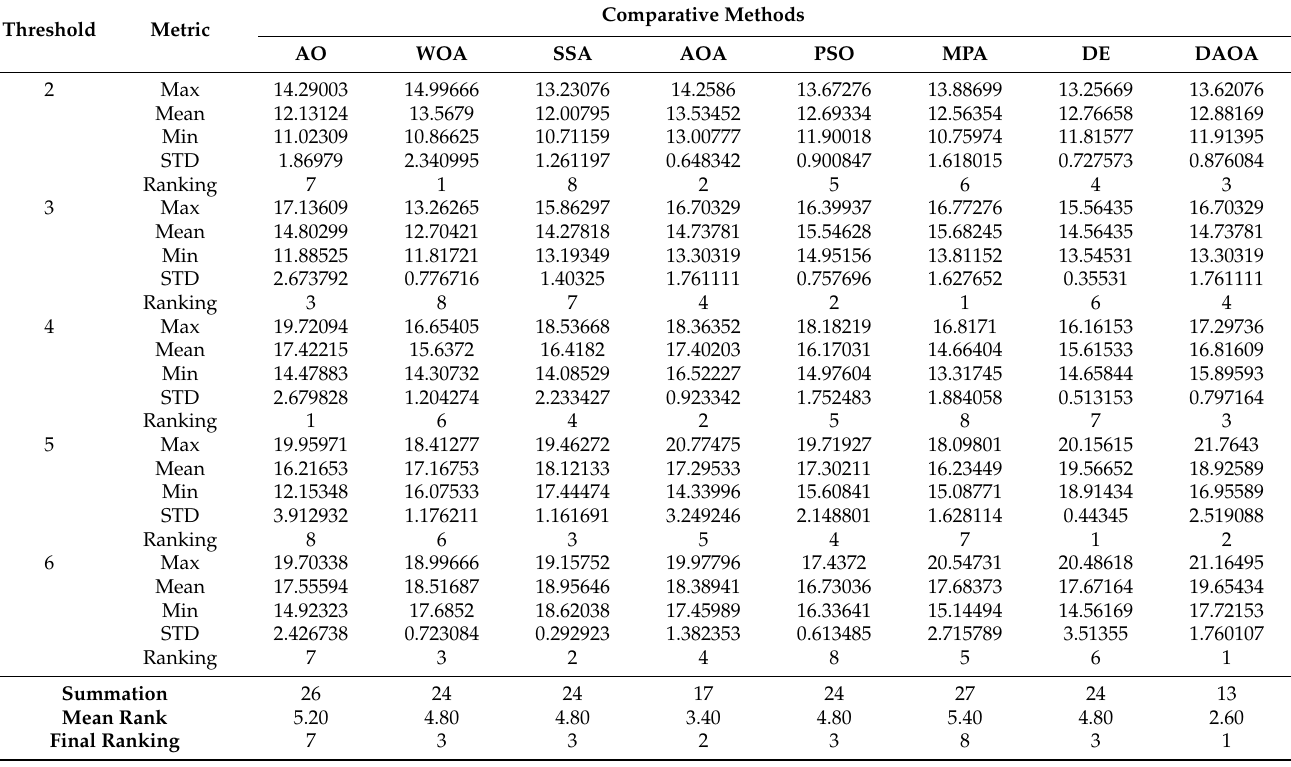
Table 12. The PSNR results of the test case